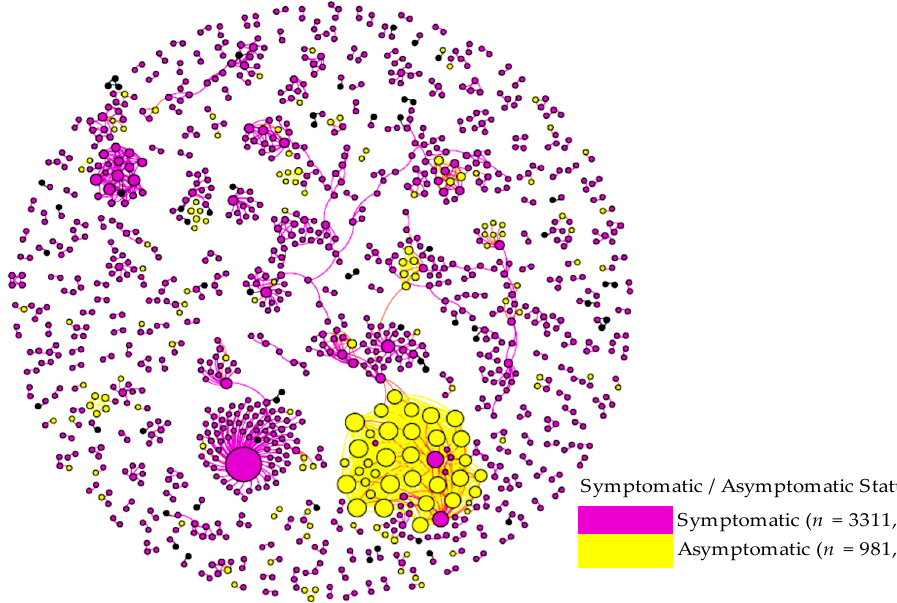
Figure 5. Symptomatic/Asymptomatic Status in Viral Transmission Networks (Hokkaido and Kanagawa). The homophily of asymptomatic and symptomatic cases is shown. Most asymptomatic COVID-19 patients cause downstream infections that are also asymptomatic. Circle size denotes impact (number of infectees).